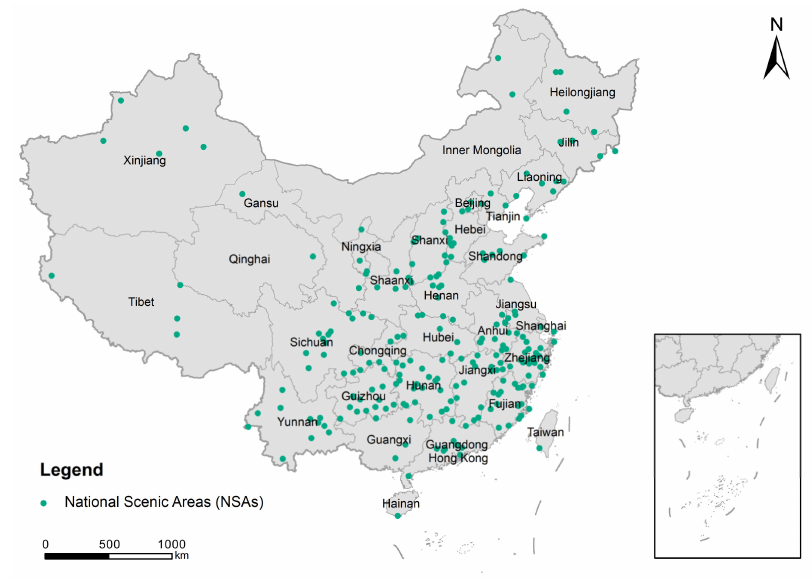
Figure 2. The map of National Scenic Areas’ distribution in